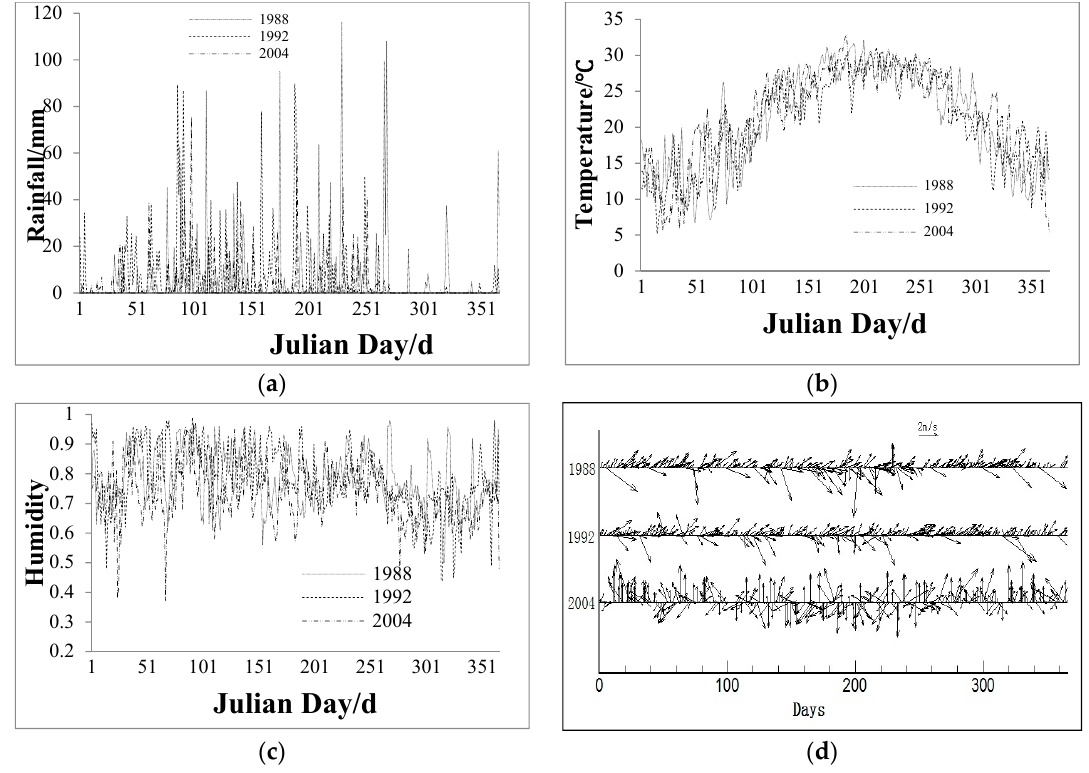
Figure 4. Time series of daily rainfall ( a ); temperature ( b ); humidity ( c ); and wind forcing ( d ) in the years of 1992, 1988, and 2004 nearby CTR.